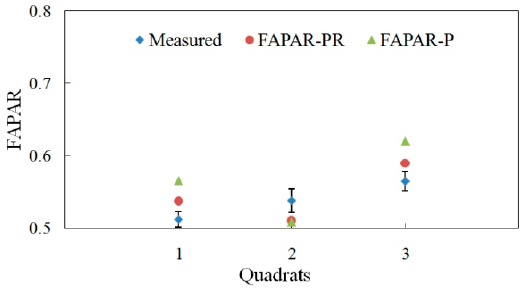
Figure 8. Measured and calculated FAPAR in three quadrants in the Saihanba forest study region: ( 1 ) Pinus sylvestris var. mongolica Litv. ; ( 2 ) Larix gmelinii (Rupr.) Kuzen. ; ( 3 ) Betula platyphylla Suk.